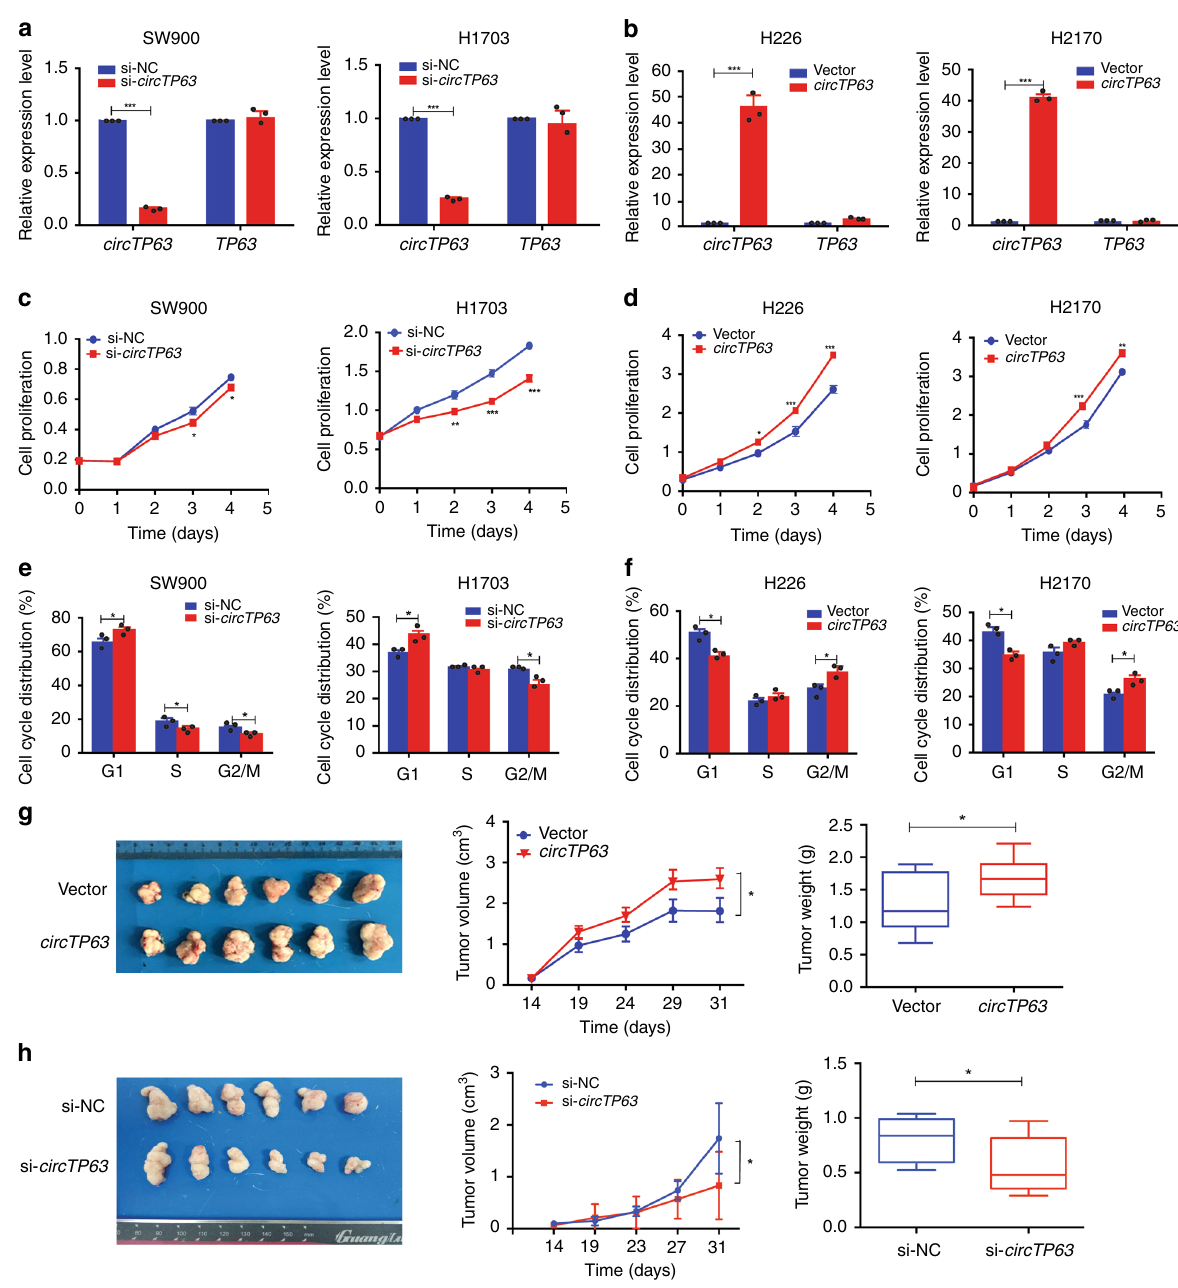
Fig. 3 c ircTP63 promotes cell proliferation and tumor growth both in vitro and in vivo. a Expression levels of circTP63 and TP63 in SW900 and H1703 cells treated with circTP63 siRNA. b Expression levels of circTP63 and TP63 in H226 and H2170 cells after transduction with circTP63 lentivirus. c and d Cell proliferation analysis of LUSC cells with silencing or stably overexpressing circTP63 . e and f Cell cycle analysis of LUSC cells with silencing or stably overexpressing circTP63 . g The volume and weight of subcutaneous xenograft tumors of H2170 cells isolated from nude mice. h The volume and weight of subcutaneous xenograft tumors of H1703 cells isolated from nude mice; center line: median of data; Bounds of box: the second quartile to the third quartile; Whisker: minimum value to maximum value. The error bars a – h represent s.d. (in a – f , n = 3; in g and h , n = 6). * p < 0.05; ** p < 0.01; *** p < 0.001, two-tailed t -test. Source data are provided as a Source Data fi